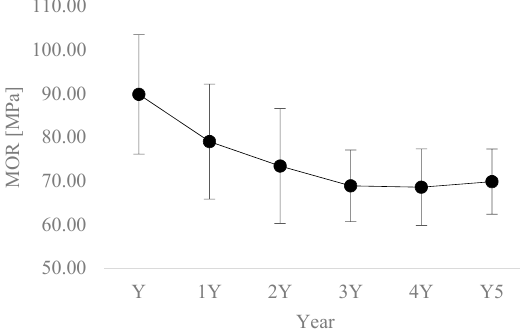
Figure 3. Resilience to static bending (MOR) of spruce wood in reference to the time since the tree’s decay.